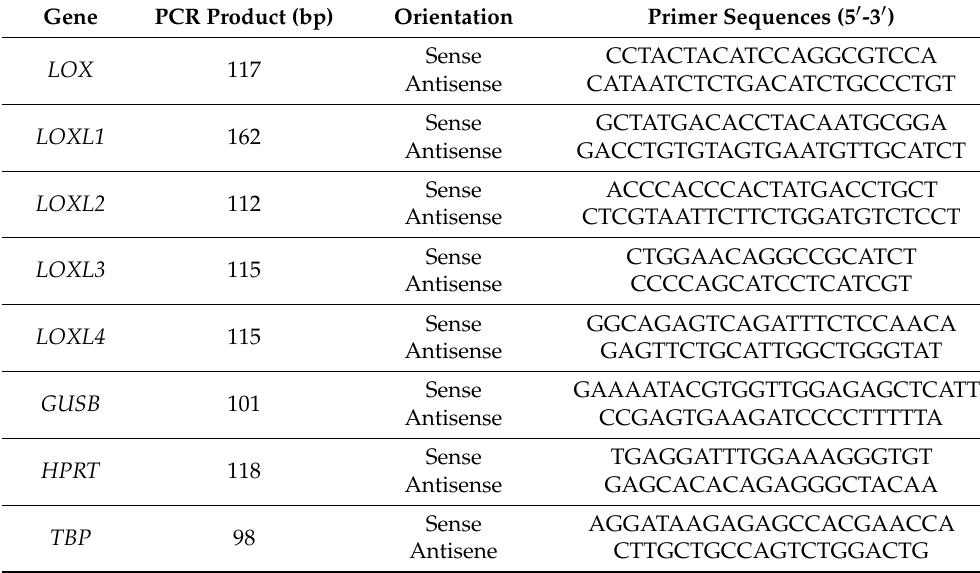
Table 1. Oligonucleotides for RT-qPCR